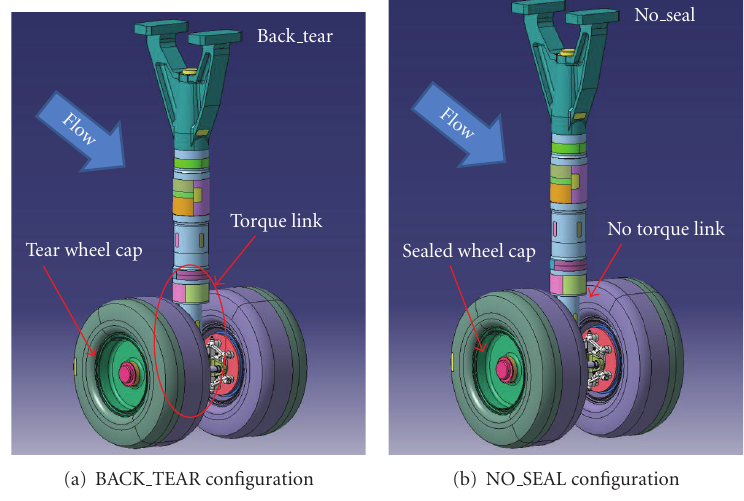
Figure 5: Simplified LEG geometries for computation.